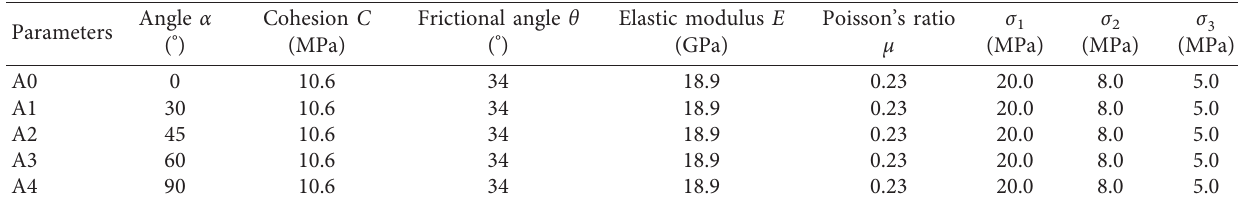
Table 4: Parameters of the calculation model.